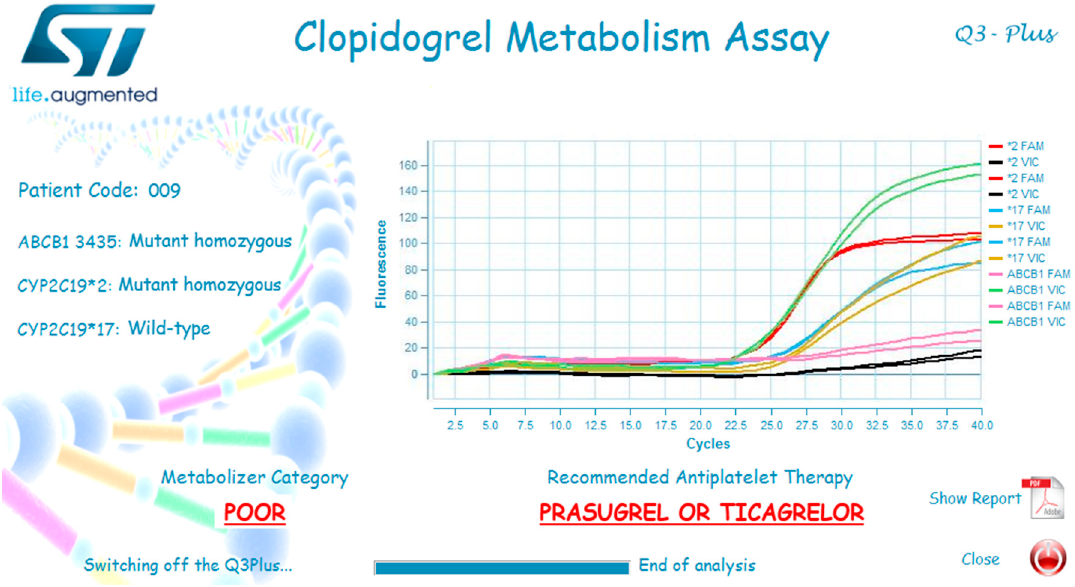
Figure 15. The Q3 software dedicated to the analysis of patients’ genotype for clopidogrel response. At the end of the analysis, the software clearly shows the diagnostic interpretation of raw qPCR results—in this case, which drug to administer to a patient, depending on her/his genotype.